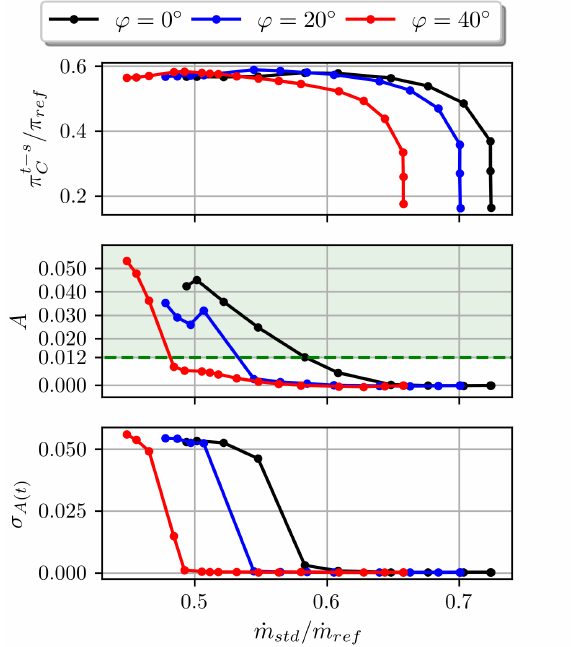
Figure 6. Evolution of the alternate pattern with respect to standard mass flow rate at at IGV stagger angles of 0 ◦ , 20 ◦ , and 40 ◦ : total-to-static pressure ratio ( top ), steady alternate rate ( middle ), and unsteady alternate rate standard deviation ( bottom ).